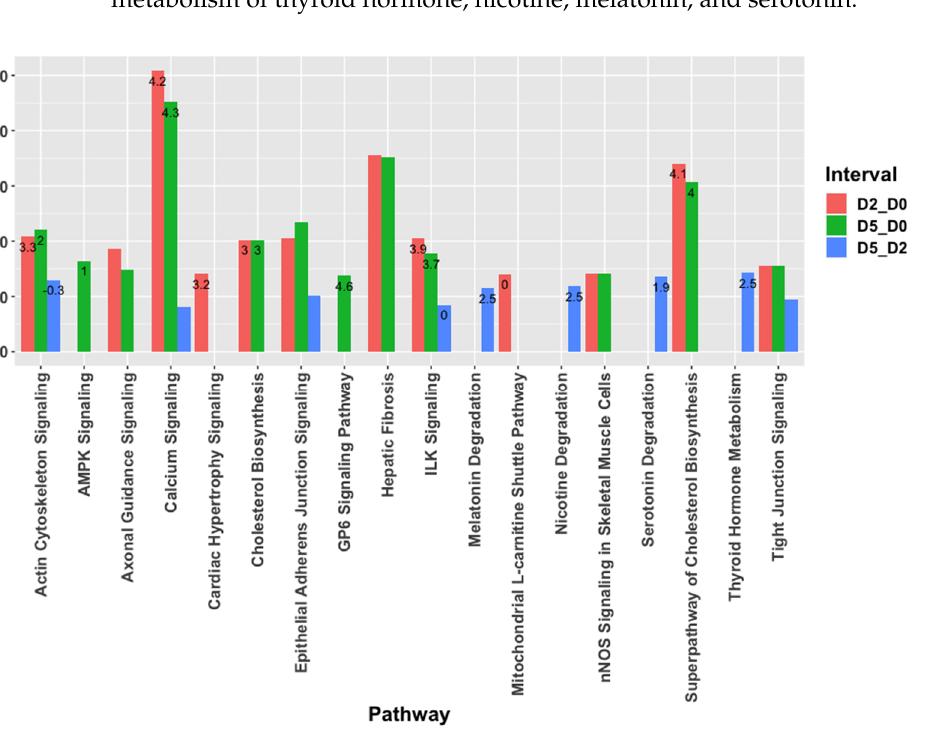
Figure 2. Top functional enrichments among differentially expressed mRNAs during muscle differentiation. Only the most significantly enriched term among closely related terms was included. Z-score for pathway activity is written on the relevant bar where applicable.